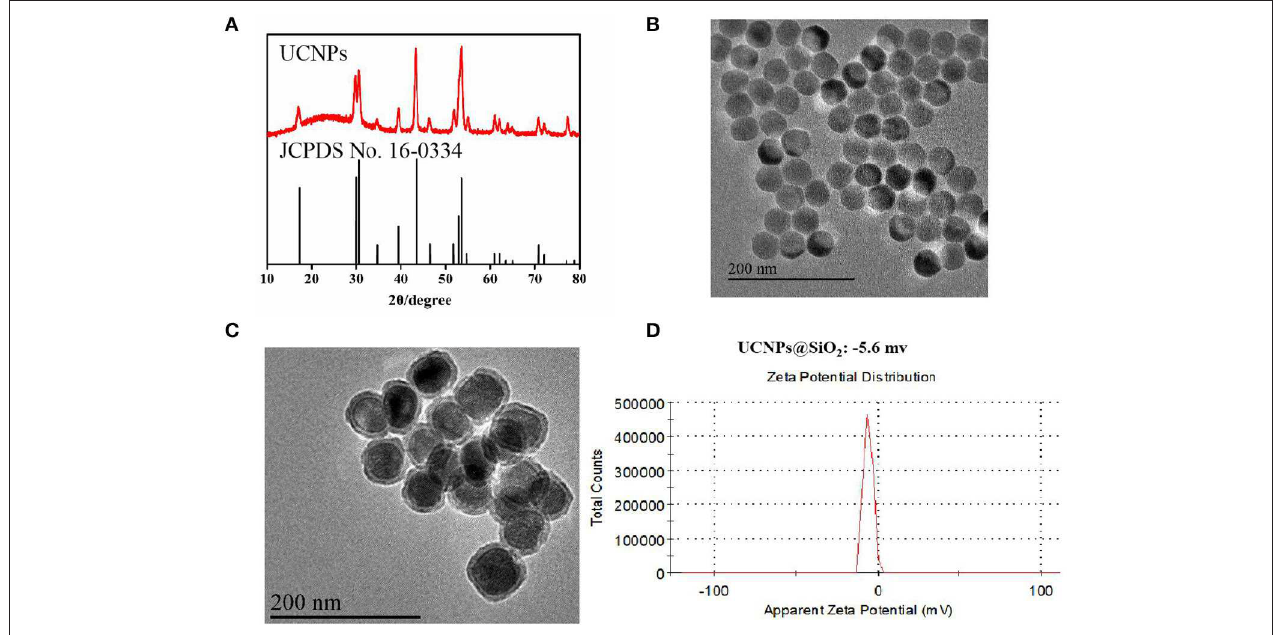
FIGURE 1 | (A) XRD images of the prepared UCNPs; (B) TEM images of the prepared UCNPs; (C) TEM images of the prepared UCNPs@SiO 2 ; (D) Zeta-potential of the prepared